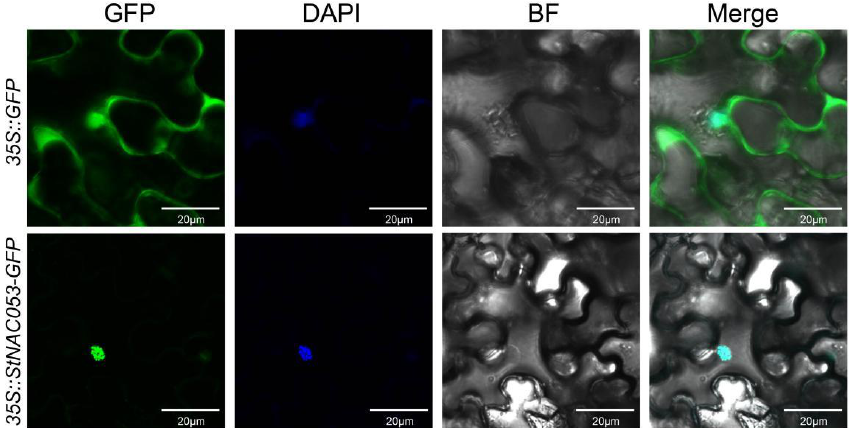
Figure 4. The subcellular localization of StNAC053 in N. benthamiana epidermal cells. GFP